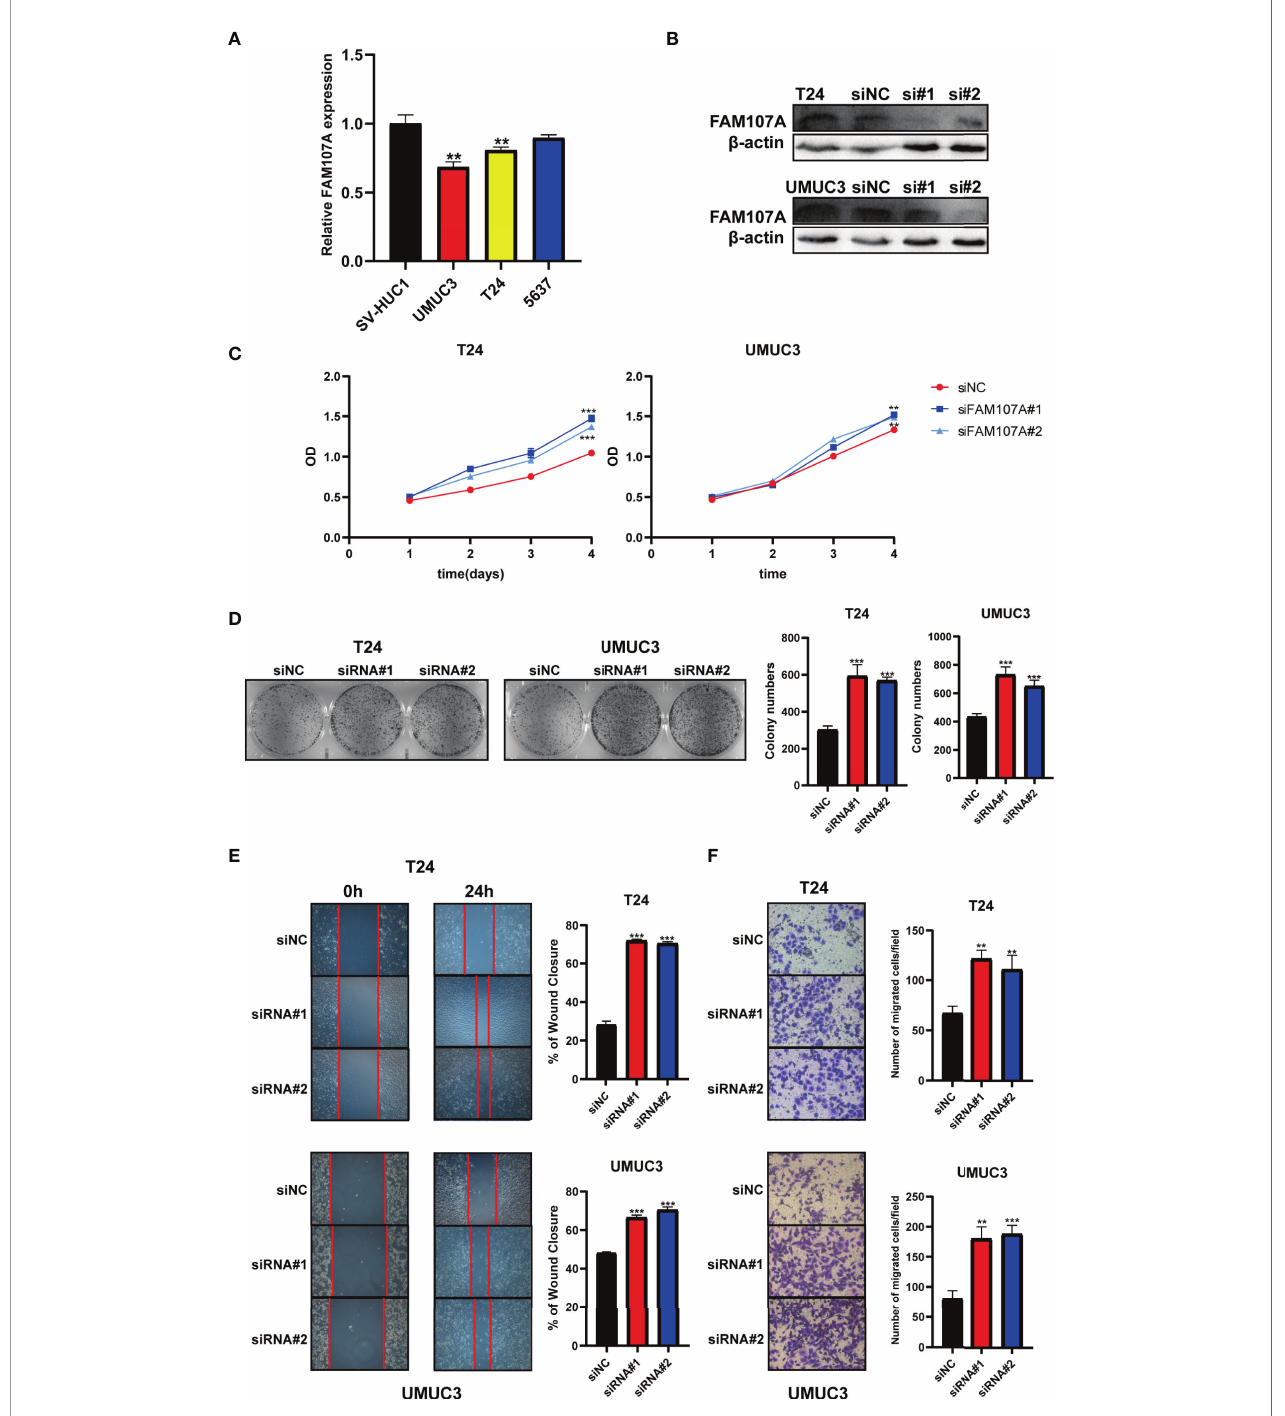
FIGURE 7 | Knockdown of FAM107A promoted the proliferation, migration, and invasion of bladder cancer cells. (A) The expression level of FAM107A mRNA was evaluated in SV-HUC1 and various bladder cancer cell lines by qRT-PCR. (B) T24 and UM-UC3 cells were transfected with si-FAM107A, the knockdown was validated by Western blot. The proliferation of bladder cancer cells was examined by CCK-8 assay (C) and colony-formation assay (D) . (E) The migration of bladder cancer cells was examined by wound healing assay. (F) The invasion of bladder cancer cells was explored by transwell assay. Data are shown as mean ± SD. **P < 0.01; ***P <